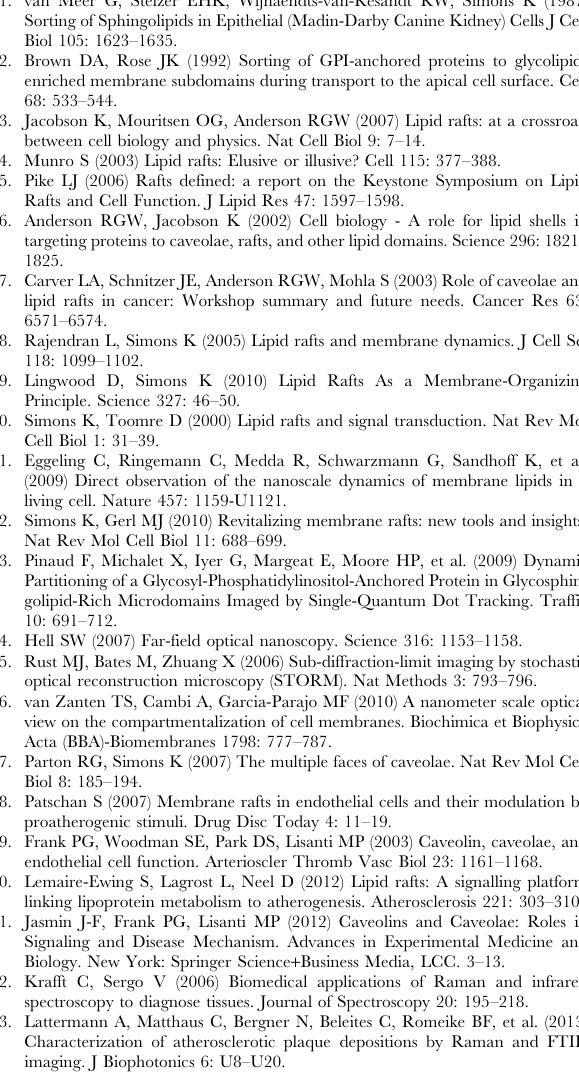
Figure S5 Statistical analysis of relationship between lipid-to-protein ratio vs area of rafts. The raw data: area of rafts (calculated based on AFM images) and lipid-to-protein ratio (computed based on Raman images) (A) were used to create a plot (B). The statistics results (C): R Spearman and p-value was calculated with 5% level of decision for two data ranges: all data (red and black) and after rejection of three outliers (red). The Spearman’s rank correlation coefficient was calculated because the Normality Test (Shapiro-Wilk) showed that the studied population cannot be considered a normal distribution population (with 5% level of decision). The obtained p-value equals 0.0025 (is considerably lower than 0.05) showing significant correlation and considerable increase of the lipid content with increasing area of lipids